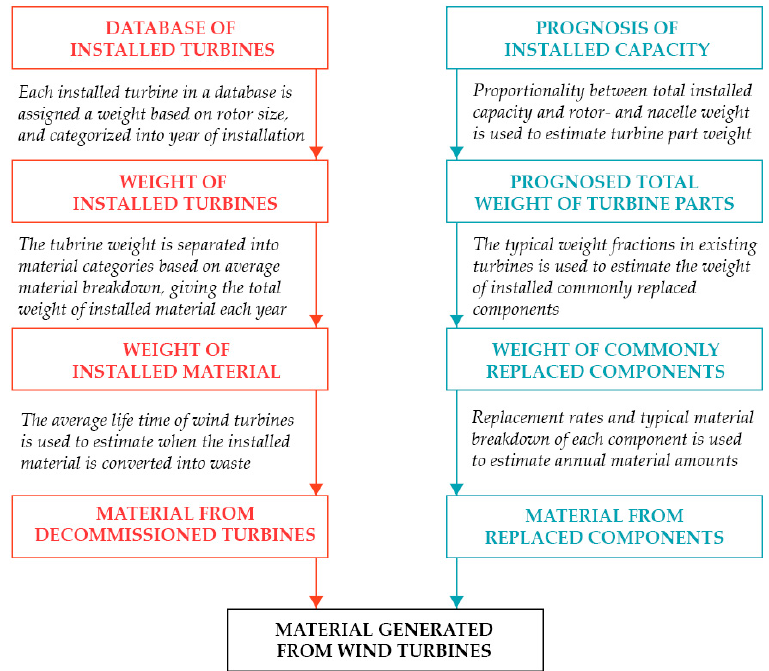
Figure 1. The workflow for estimating material generated from wind turbines. Materials from decommissioned turbines and material from replaced components are calculated separately and then combined into total material amounts.